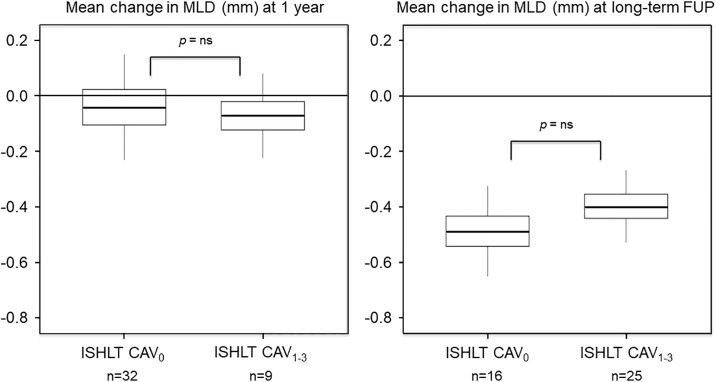
Quantitative angiographic analysis.Box-plot representation of the per-patient mean angiographic change in minimal lumen diameter (minimal lumen diameter 1 year—minimal lumen diameter baseline and minimal lumen diameter latest angiographic follow-up—minimal lumen diameter baseline) from coronary artery segments that were serially assessed and matched. The analysis is stratified according to absence (n = 16) or presence (n = 25) of ISHLT-CAV at 1 year, and at latest angiographic follow-up (median 8.61 years [8.24 to 8.99]). Lower and upper box edges are the quartiles and thick line is the median. A horizontal reference line at change = 0 is drawn.